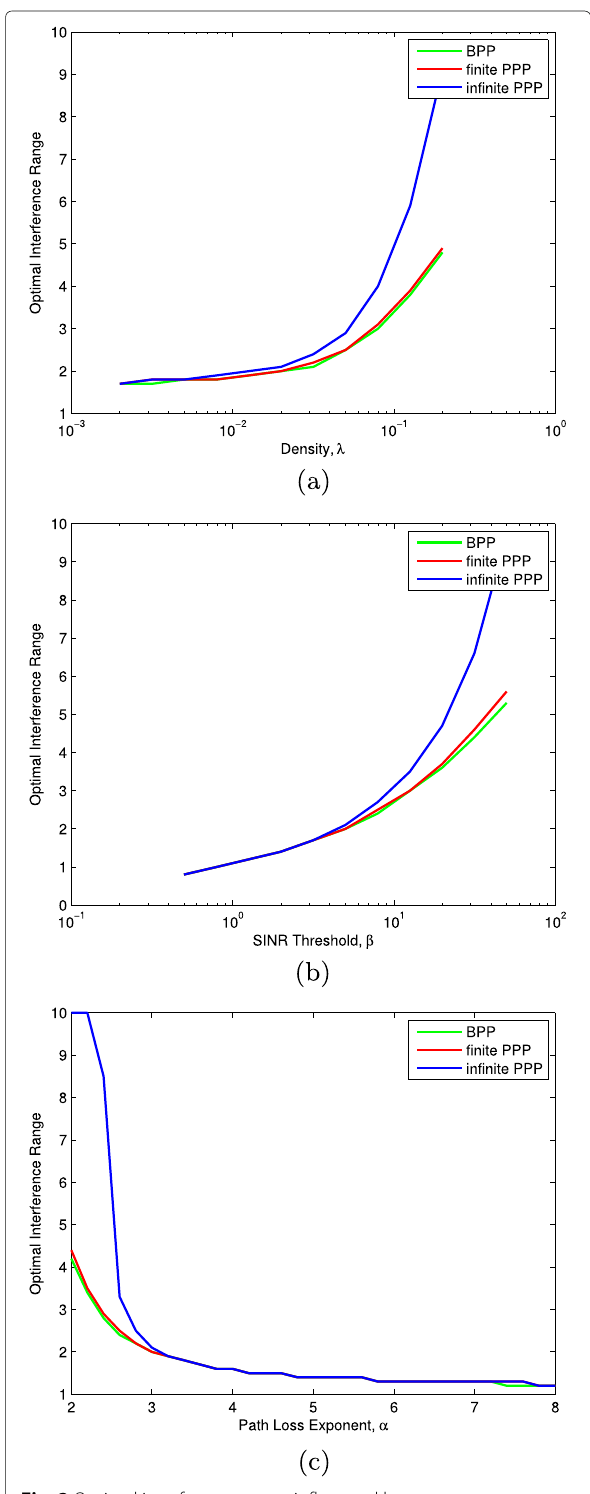
Fig. 2 Optimal interference range influenced by parameters. a Optimal interference range vs. density λ . b Optimal interference range vs. SINR threshold β . c Optimal interference range vs. path loss exponent